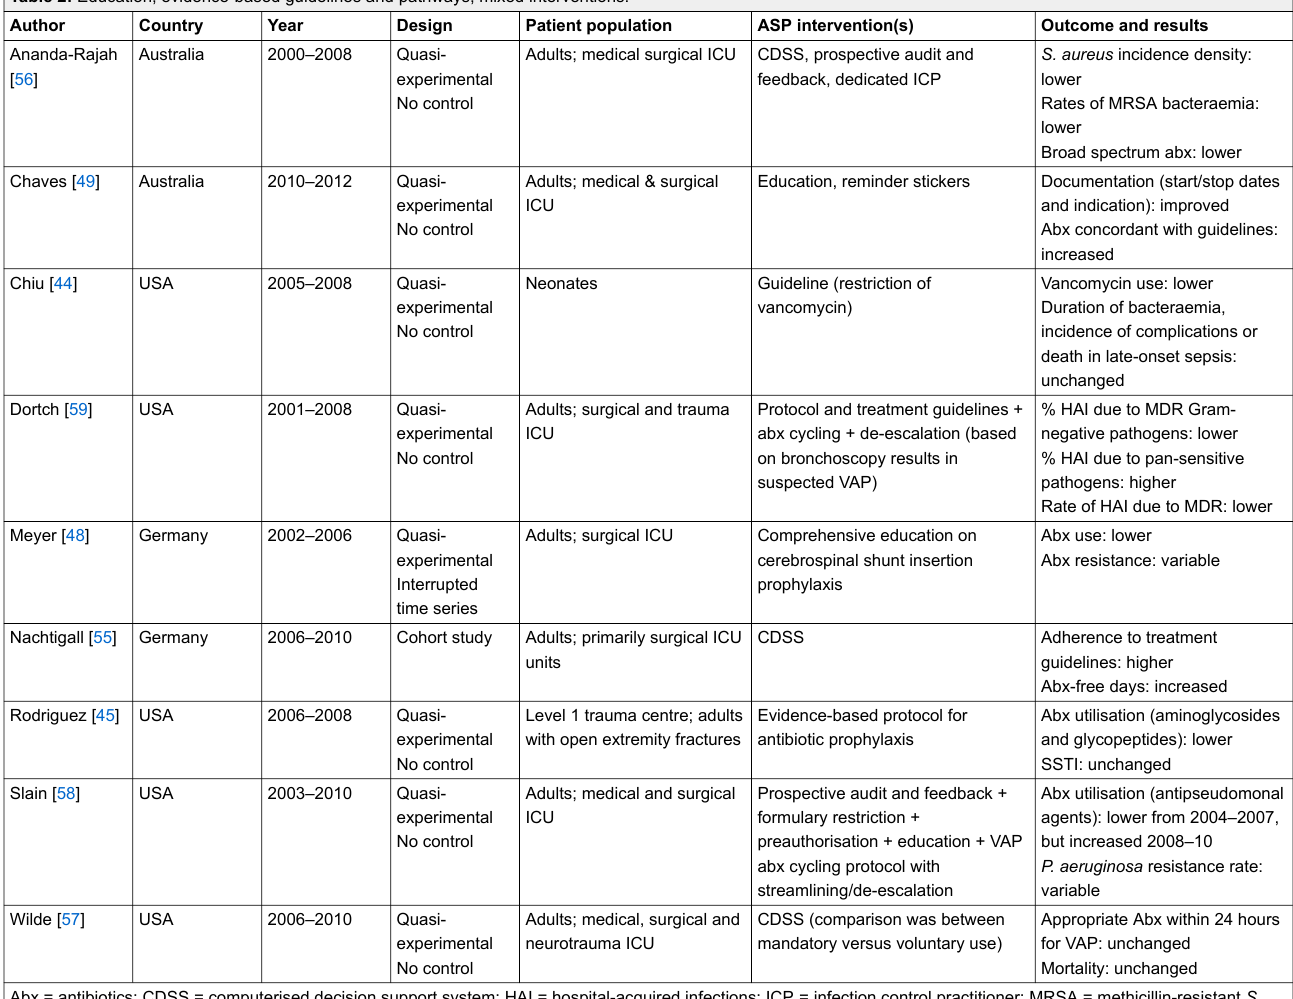
Table 2: Education, evidence-based guidelines and pathways, mixed